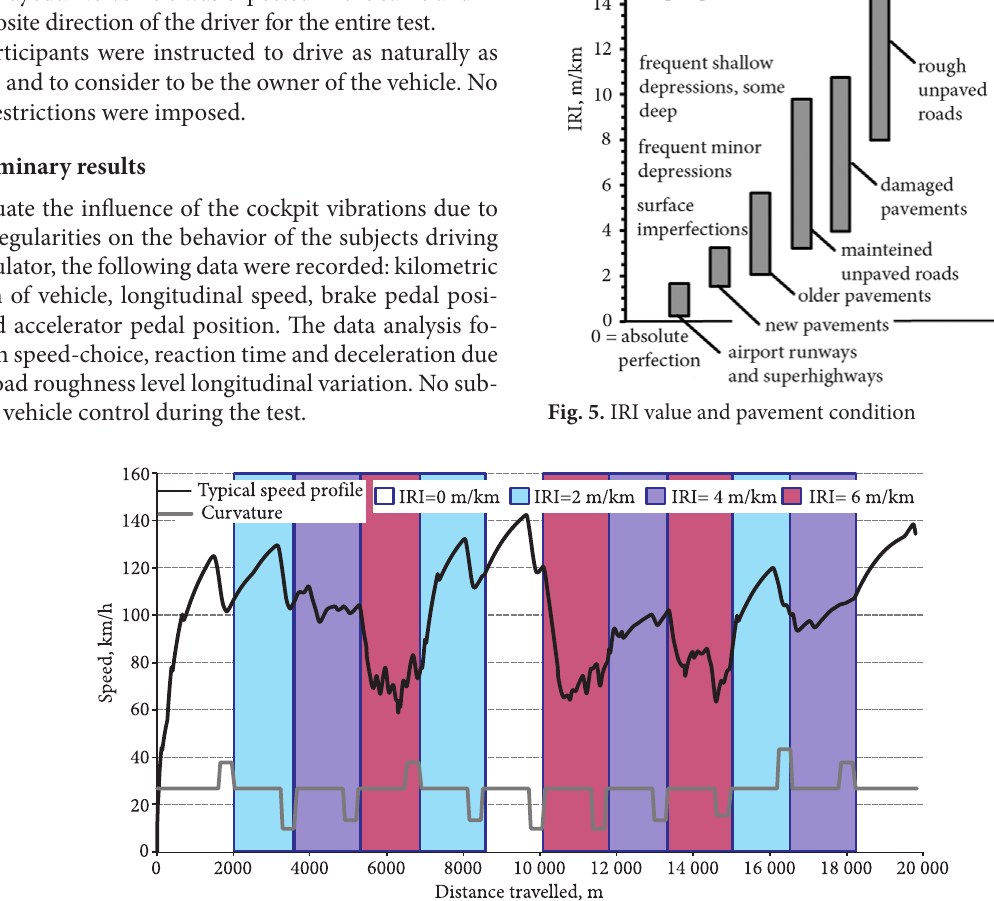
Fig. 6. Typical speed